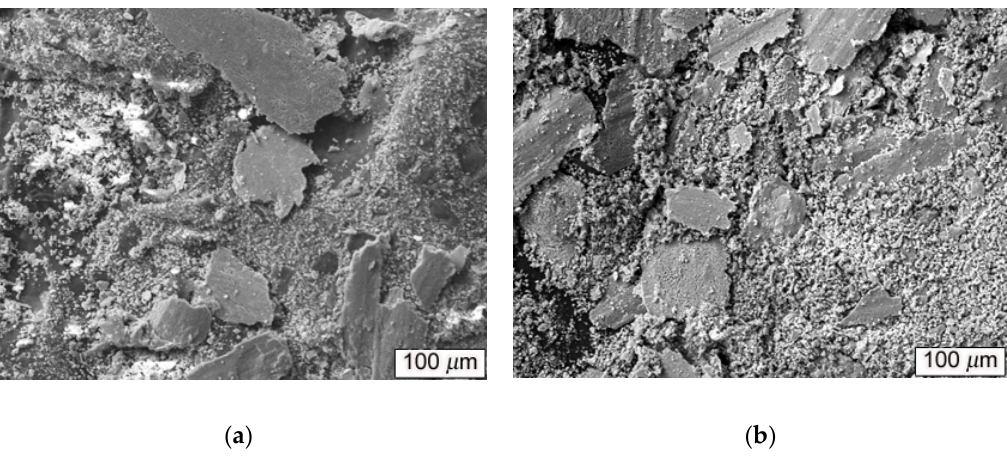
Figure 6. SEM of wear debris on Mg 2 Si–Al composites fabricated by ( a ) gravity casting and ( b ) semi-solid extrusion with isothermal heat treatment holding time of 60 min, with 50 N applied load.